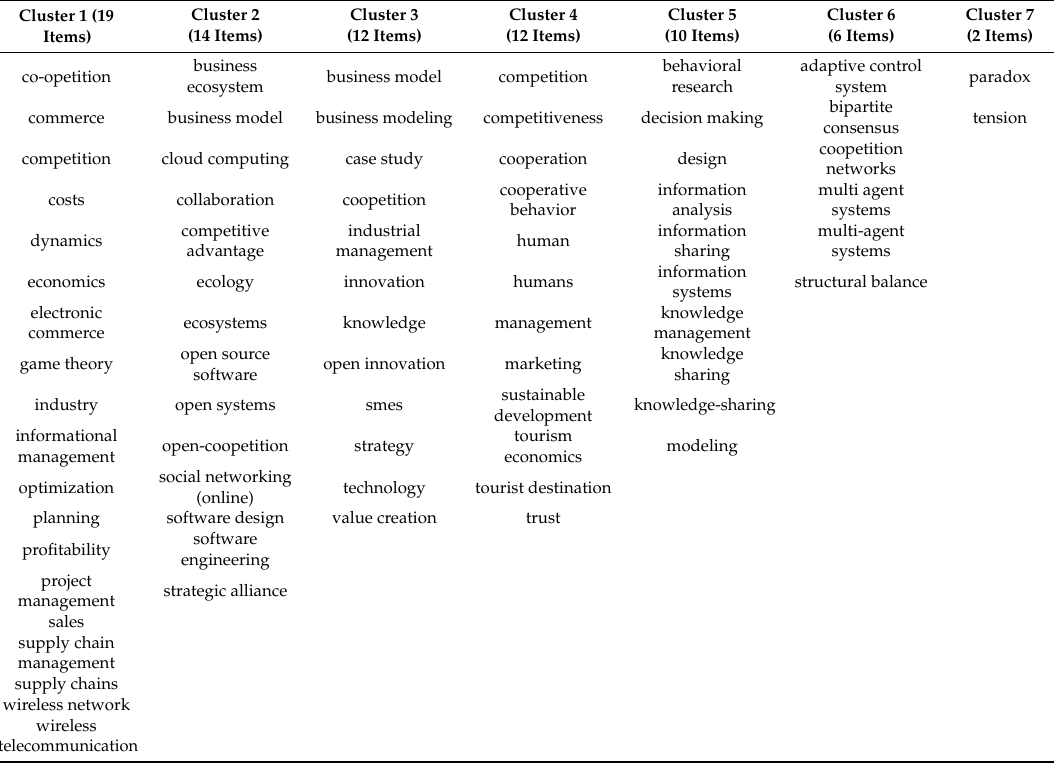
Figure A1. Network visualization of most frequent terms (Constructed via VOSViewer v.1.6.10 for the sample N = 664, f (frequency) > 6). Table A1. Results of clustering the papers in the area of coopetition research (VOSviewer clasterization technique).